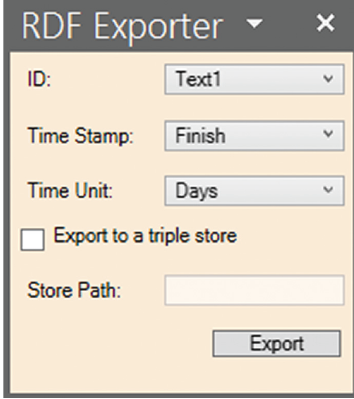
Figure 6: The interface of the schedule